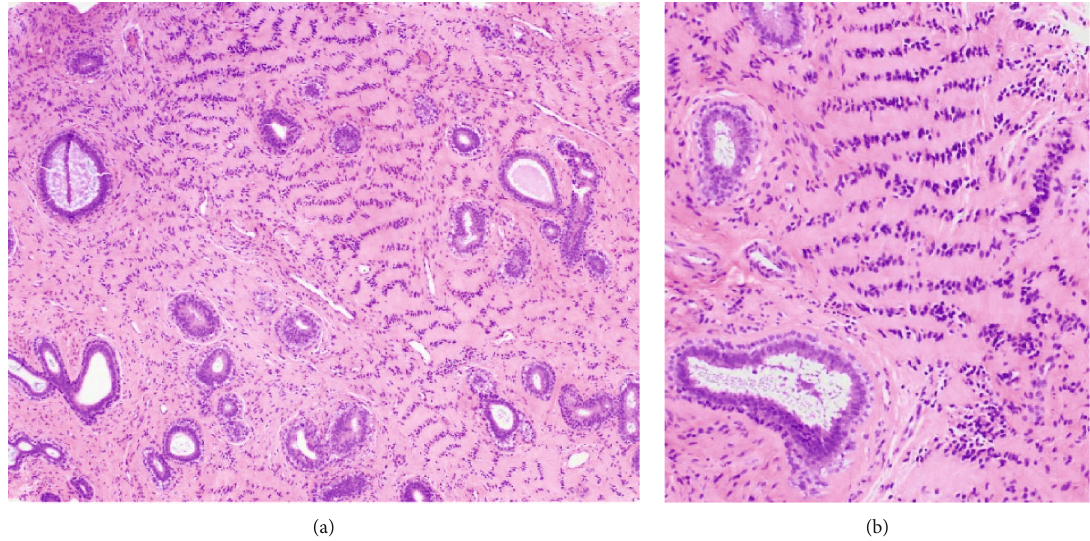
Figure 2: Low-power histologic assessment shows scattered nonneoplastic breast epithelial elements including scattered ducts and the edge of a terminal duct lobular unit with stromal expansion between and within these epithelial structures. Eosinophilic expanses of fi brous tissue are noted with linear arrangements of spindle cell nuclei resulting in a tiger-stripe-like pattern ((a) hematoxylin and eosin, 100X). At intermediate magni fi cation, the nuclear arrangements with o ff set eosinophilic cytoplasmic bands emphasize the striped morphology ((b) hematoxylin and eosin,